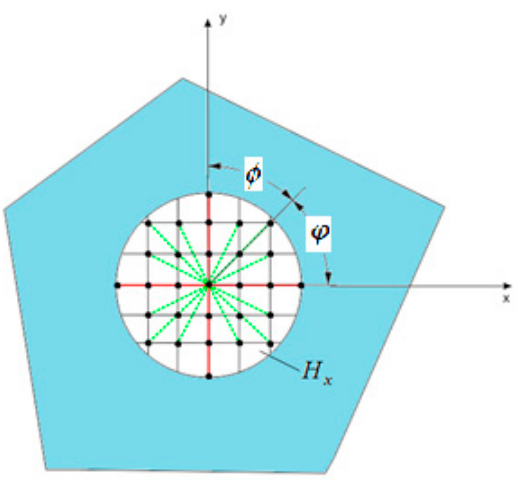
Figure 2. Type 1 bonds (green dashed lines) and Type 2 bonds (red solid lines) for the OSB PD cubic crystal model for a grain orientation of ϕ = π